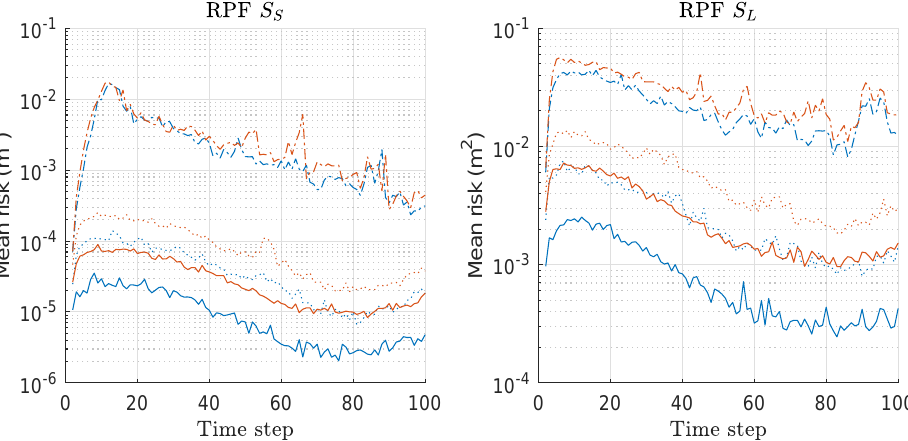
Figure 8. Mean-risk over 300 runs with 1000 particles based on Equation (20) for RPF and MRPF. Results regarding only r x are shown, and those regarding r y showed similar results. Legend: line style (dash-dot: M = 2; dotted: M = 5; solid: M = 10); (line color: blue: RPF; red: MRPF).